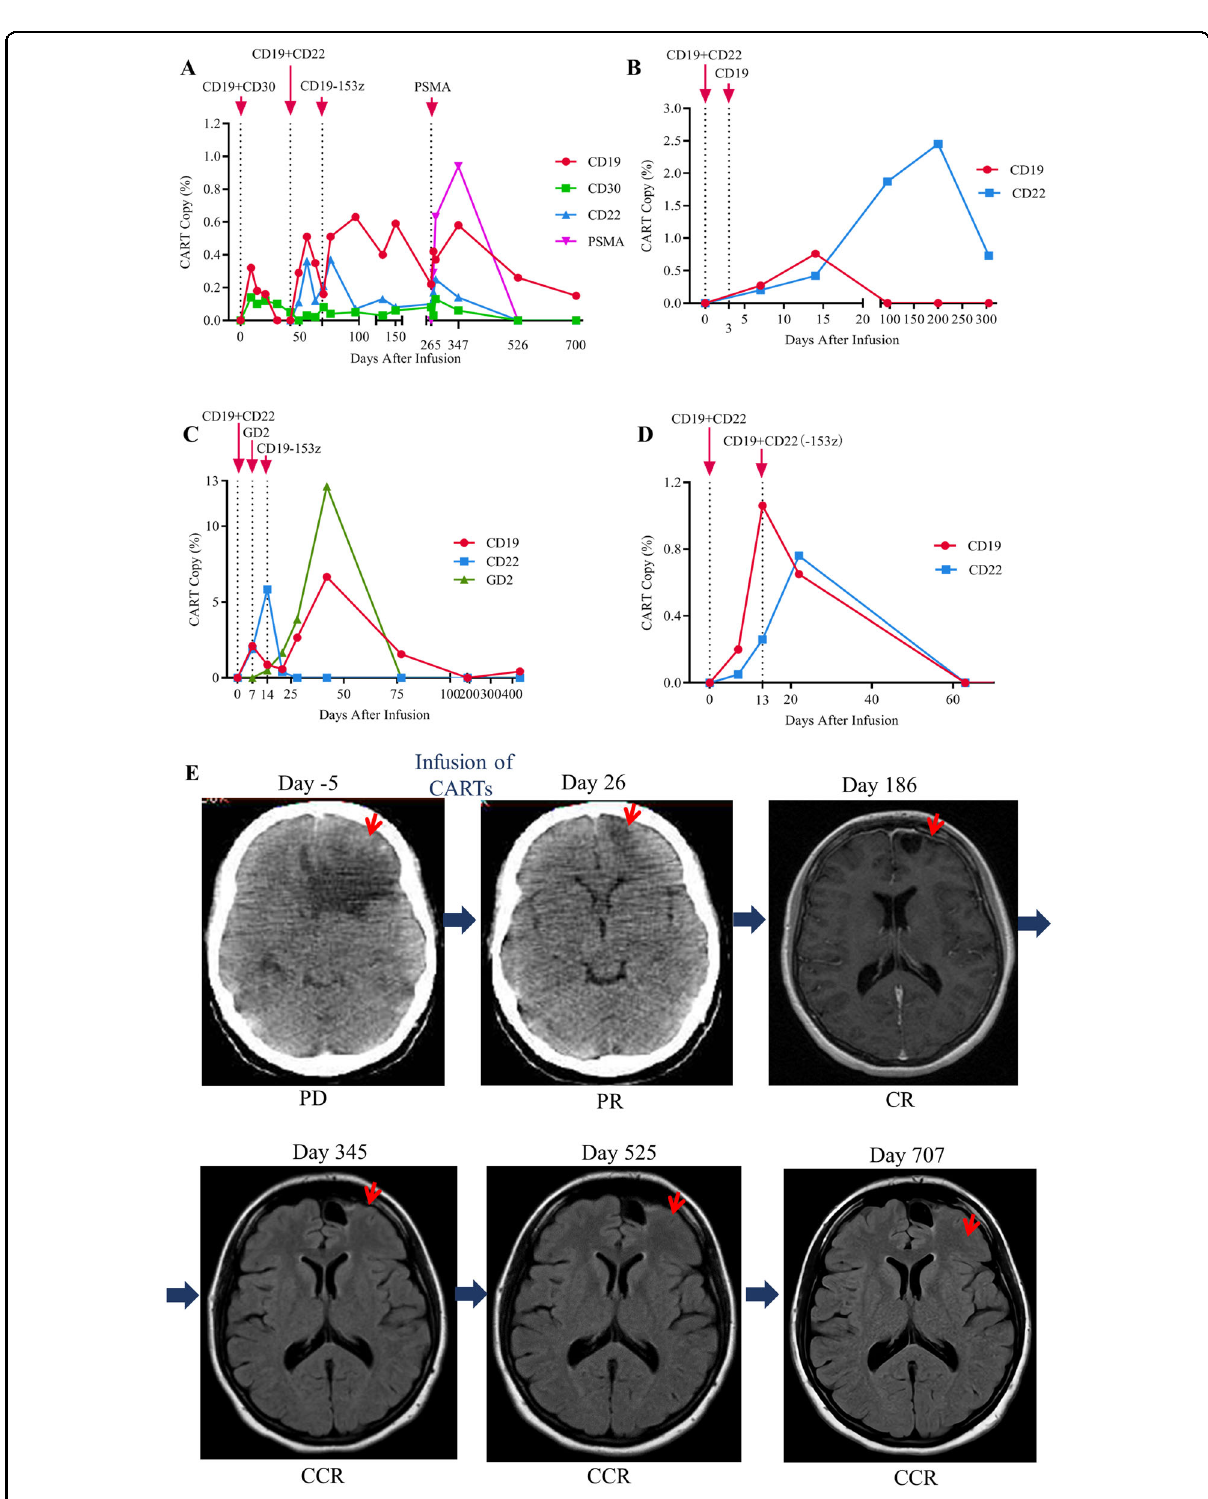
Fig. 1 The kinetics of CAR-T cell expansion in the peripheral blood and scan images. A The copy number of CD19, CD22, CD30, and PSMA CAR- T cells in the peripheral blood of pt 1. B The copy number of CD19 and CD22 CAR-T cells in the peripheral blood of pt 2. C The copy number of CD19, CD22, and GD2 CAR-T cells in the peripheral blood of pt 3. D The copy number of CD19 and CD22 CAR-T cells in the peripheral blood of pt 4. E FDG- PET/CT and MRI scans of the brain lesions before and after CAR-T treatment of pt 1. Arrows point to the FDG-positive lesion in the left inferior frontal lobe before and after CAR-T. PD progressive disease, PR partial response, CR complete response, CCR continued complete